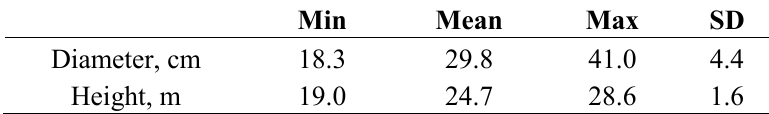
Table 1. Tree statistics calculated from the field